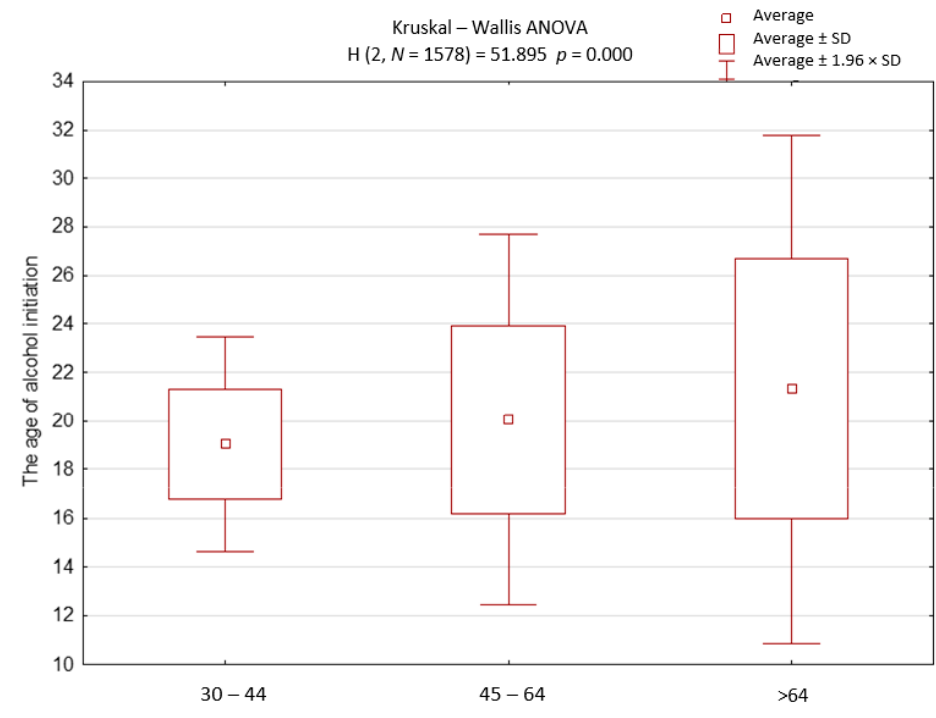
Figure 2. The age of the initiation of alcohol in different age groups. The odds ratio (with 95% CI) for occurrence of diabetes (a), hypertension (b), CVD (c), and hepatitis or jaundice (d) in groups of participants differentiated by attitudes toward alcohol consumption are presented in Figure 3. In the model, attitudes toward alcohol consumption have been adjusted to age. Current drinkers had almost 1.5-fold higher odds of diabetes than never drinkers (OR 1.49; CI 1.03–2.17). Former drinkers had higher odds for hypertension than never drinkers (1.73; CI 1.05–2.85). Both current and former drinkers had higher odds for CVD than never drinkers (OR 1.66, CI 1.27–2.18; OR 1.76, CI 1.22–2.53, respectively). We found no significantly higher odds for the occurrence of hep- atitis/jaundice between current, former, and never drinkers. The odds of occurrence of diabetes, CVD, and hypertension were not significantly associated with sex. On the other hand, the odds of occurrence of hepatitis/jaundice were lower in men than women (OR 0.67; CI 0.46–0.99).